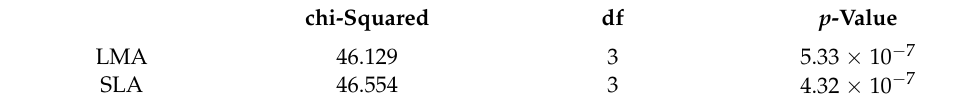
Table 4. Kruskal–Wallis rank-sum test of the two leaf traits Vegetation structure: LMA (g cm − 2 ) = leaf